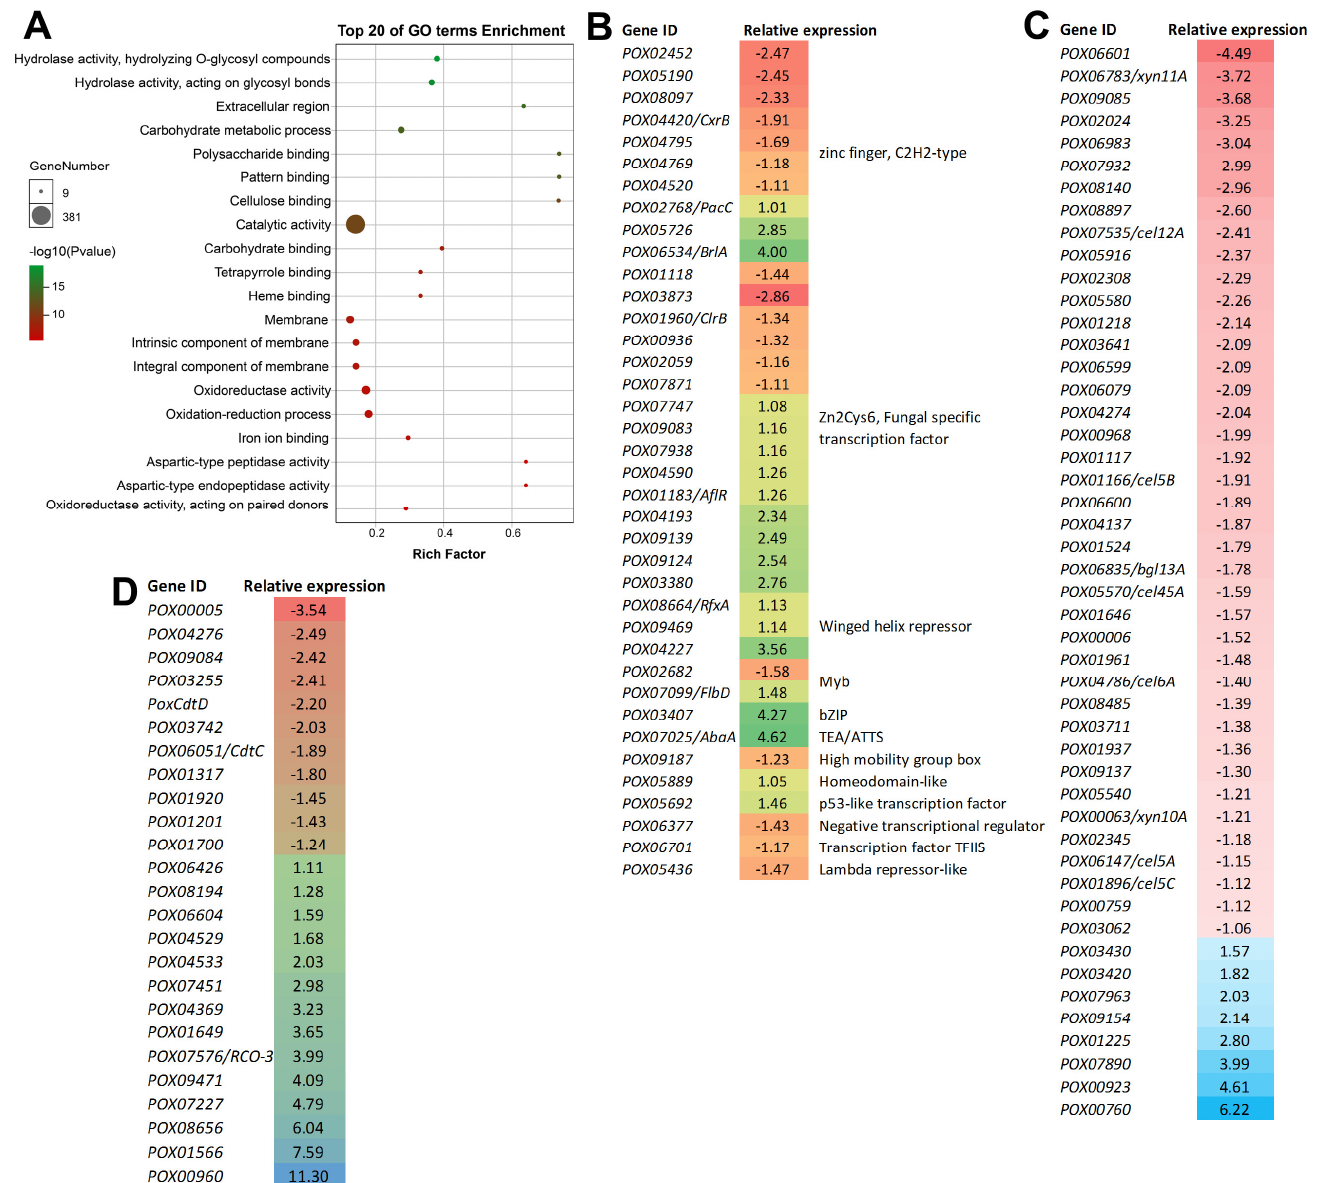
Figure 5. Transcriptomic analysis of the P. oxalicum mutant Δ PoxMKK1 and the control strain Δ PoxKu70 grown in MMM with 2.0% Avicel. Total RNAs for RNA sequencing were prepared from fungal hypha cultivated for 24 h after a shift. ( A ) The gene ontology (GO) annotation of differentially expressed genes (DEGs) for the top 20 GO terms’ enrichment. ( B − D ) Heatmap showing the transcription abundance of DEGs encoding putative CAZymes, transcription factors (TFs), and sugar transporters. FPKM, fragments per kilobase of exon per million mapped reads.